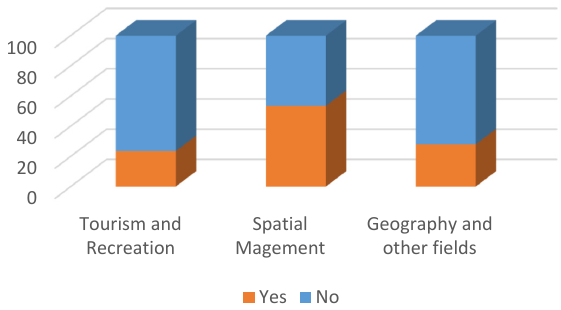
Figure 5. Survey question: Have you noticed a change in your perception of the landscape between